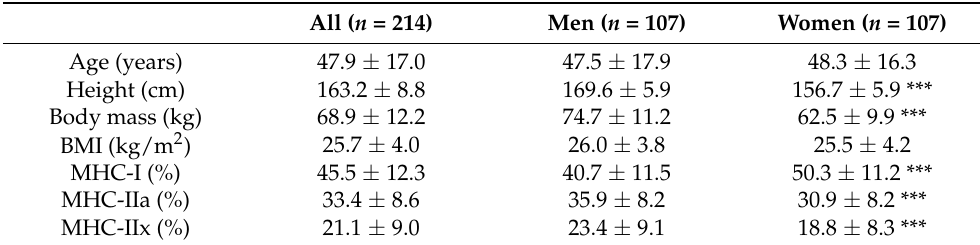
Table 1. Characteristics of the participants enrolled in this study. All ( n = 214) Men ( n =